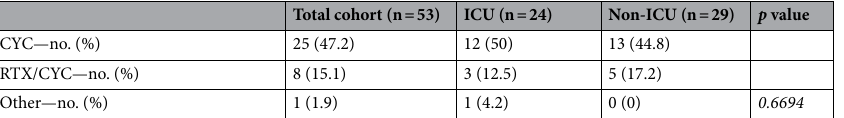
Table 1. Clinical characteristics of the total patient cohort of ANCA-associated renal vasculitis. Continuous variables are expressed as median and IQR, categorical variables are presented as frequency and percentage. For group comparisons, the Mann–Whitney U test was used to determine differences in medians. Non- parametric between-group-comparisons were performed with Pearson’s Chi-square test.